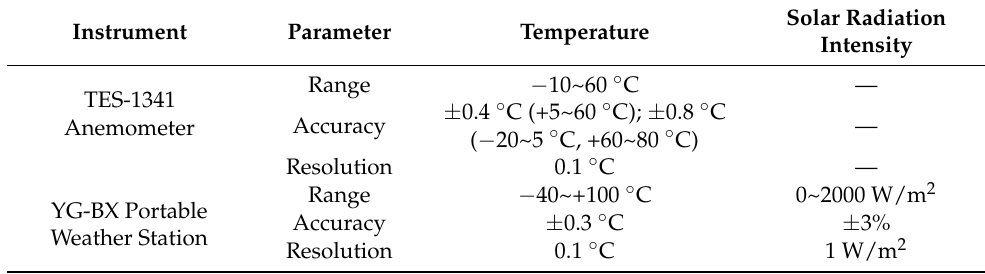
Figure 5. TES 1341 anemometer ( a ), YG-BX portable weather station ( b ). The sensors of the anemometers were located 1.1 m above the ground, which is equivalent to the center of gravity in an adult person. The YG-BX portable weather stations (Wuhan, China) (Figure 5b) were placed on the roofs of the tallest buildings in the two neighborhoods separately to collect solar radiation intensity and air temperature data, reflecting the boundary meteorological conditions of the residential estates. The weather station was approximately 100 m above the ground. The anemometer measures air temperature every 15 min, and the portable weather station measures it at the same interval. The sensor of the anemometer was covered with a tin-foil-wrapped hood to reduce the interference of direct solar radiation. The technical parameters of the instruments are listed in Table 3. Meteorological data were collected on clear and rainless days in June and August 2021 (Table 4). Table 3. Sensor specifications.